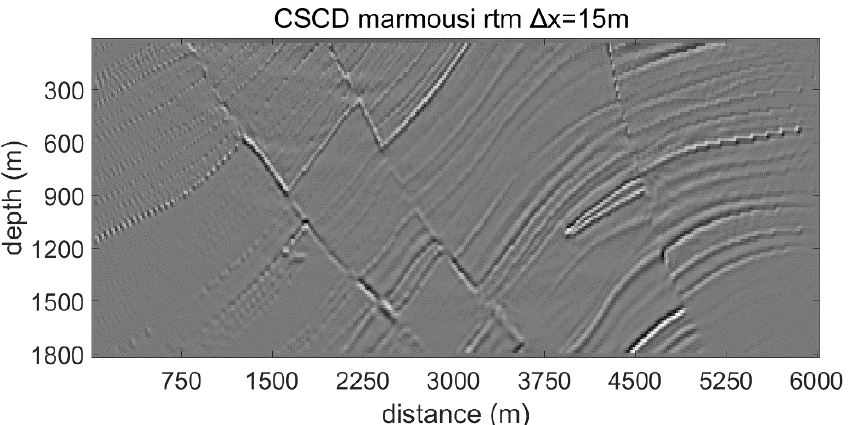
Figure 14. CCD is used to the reverse ‐ time migration result with Marmousi shear ‐ wave velocity model, Δ x = 15 m.